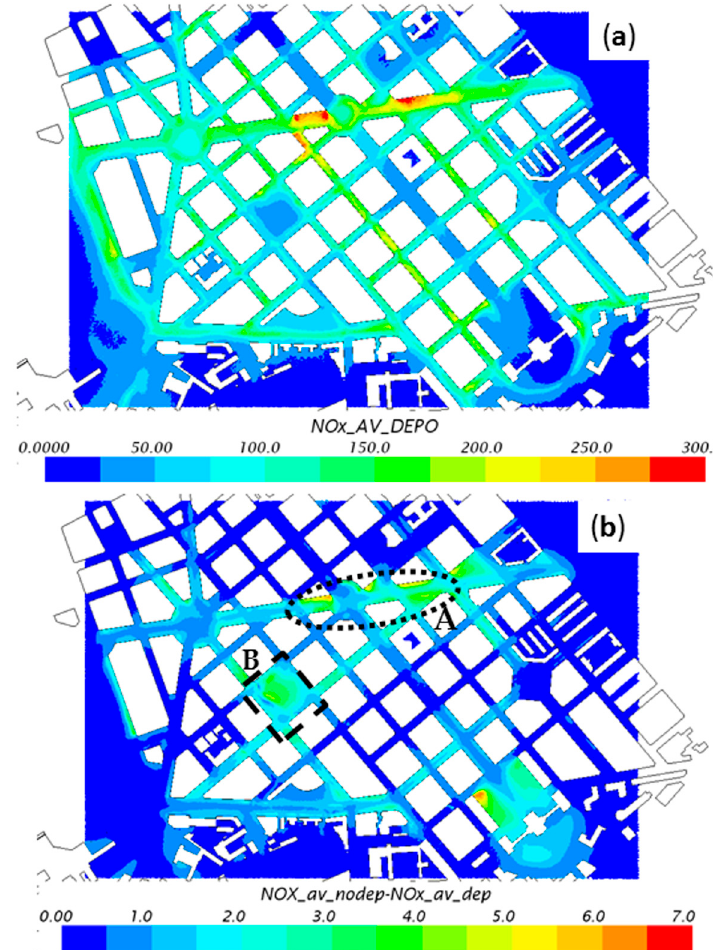
Figure 3. ( a ) Time-averaged NO x concentration taking into account pollutant deposition; ( b ) Differences of time-averaged NO x concentration due to considered deposition effect.